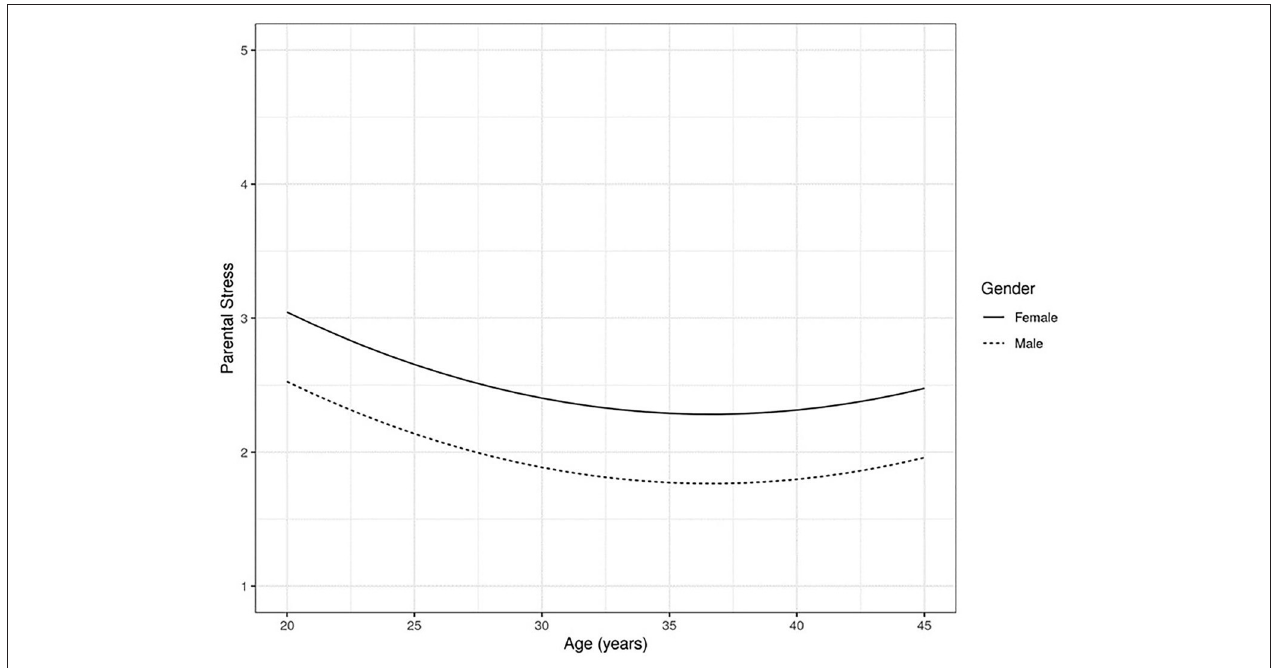
FIGURE 1 | Parental stress and parent’s age